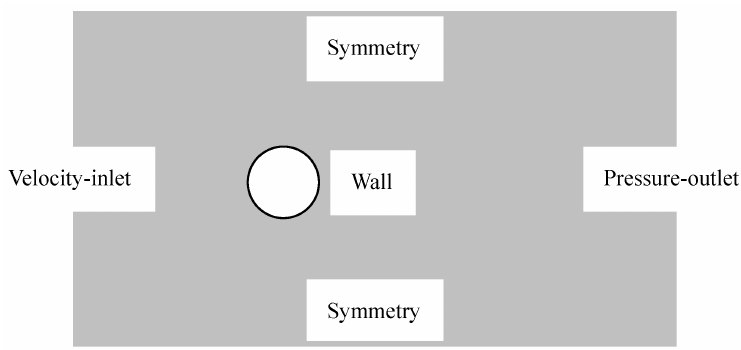
Figure 3. Boundary conditions for wind field simulation.